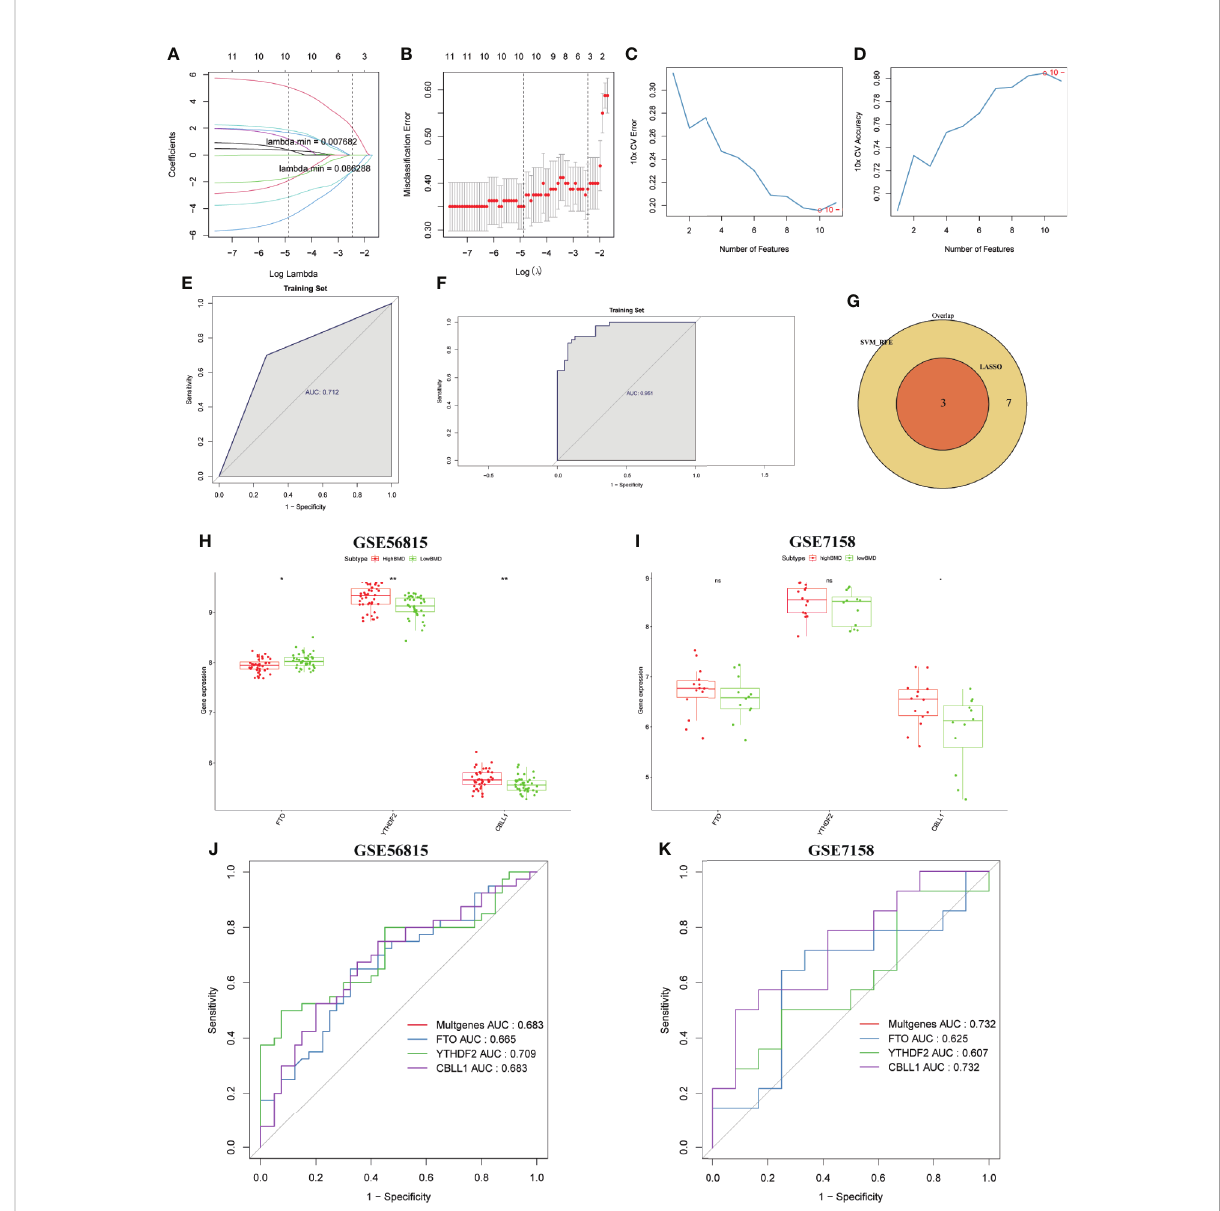
FIGURE 8 Identi fi cation and validation of the diagnostic markers for OP. (A) LASSO regression coef fi cient pro fi les of the 13 m6A regulators. Each curve represents the changing trajectory of each m6A regulator. (B) Tenfold cross-validation for optimal parameter selection in the LASSO model. Each red dot represents a lambda value with a con fi dence interval. The two dotted lines represent the values at minimum criteria and 1- standard error (1-SE) criteria by 10-fold cross-validation. The x -axis shows the penalization coef fi cient (log l ). The y -axis shows the partial likelihood deviance values with error bars. (C) The curve of the total within sum of squared error curve under corresponding cluster number k, and it reached the “ elbow point ” when k = 10. (D) The curve of average silhouette width under corresponding cluster number k, and the maximum of average silhouette width was achieved when k = 10. (E, F) ROC curves validated the performances of the LASSO regression model and the SVM-RFE model. (G) Venn plots show the candidate genes by overlapping the candidate genes selected from the LASSO regression model and the SVM-RFE model. (H, I) Boxplots showing the three differentially expressed m6A regulators (FTO, YTHDF2, and CBLL1) between high-BMD women and low-BMD women in GSE56815 and GSE7158 datasets. (J, K) ROC curves validated the performances of three m6A regulators (FTO, YTHDF2, and CBLL1) for the prediction of OP in GSE56815 and GSE7158